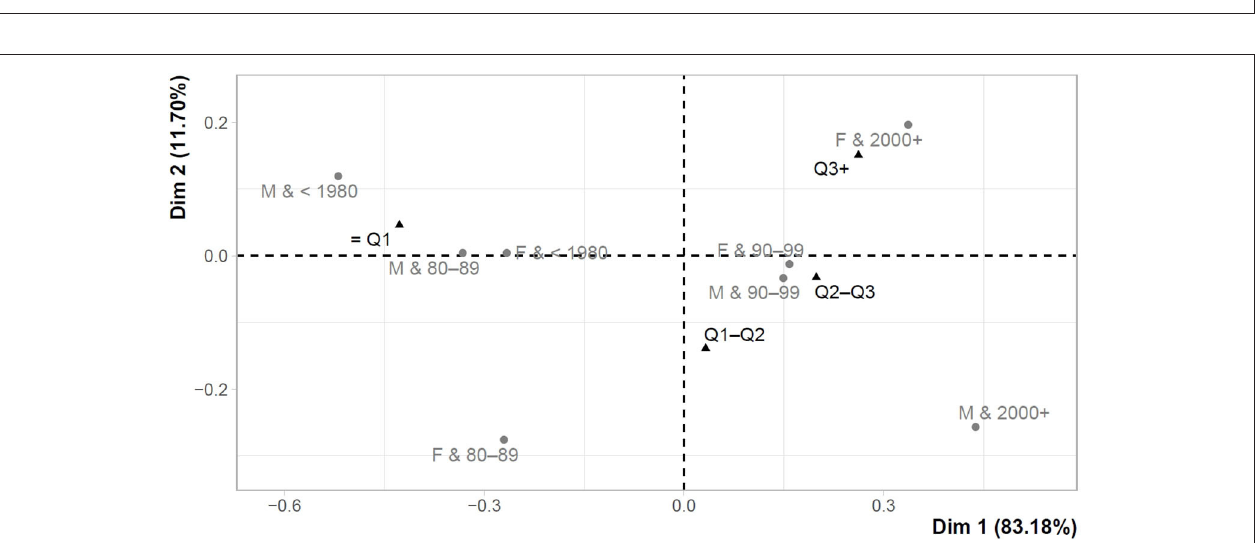
FIGURE 2 | Correspondence map–Perc_test T1 and gender-age characteristics.